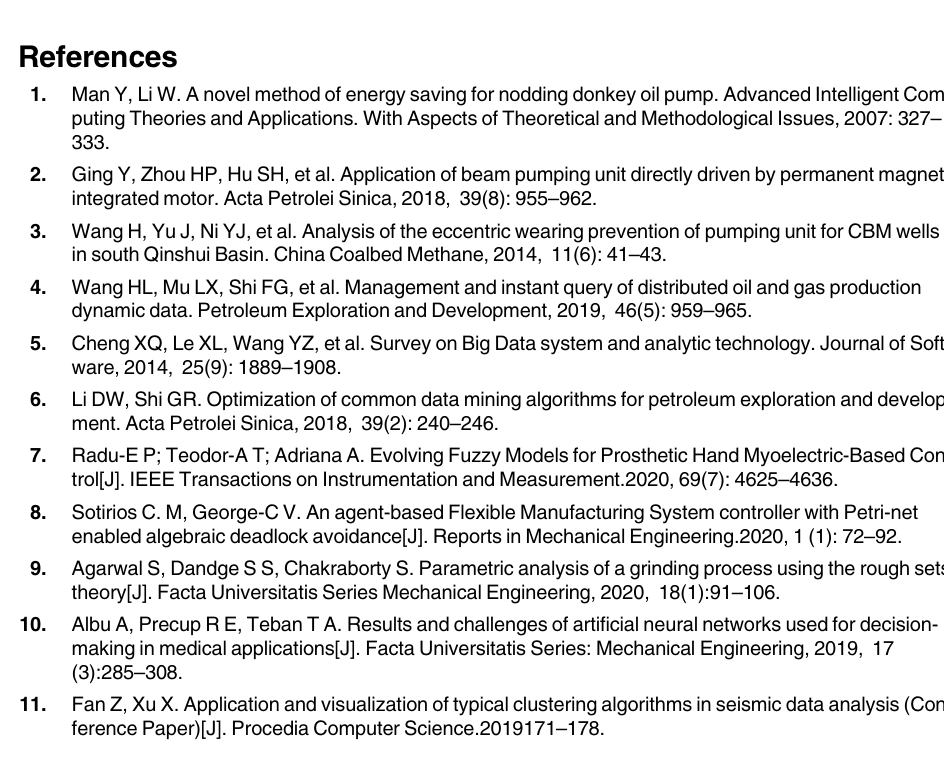
4. Using the improved algorithm clustering results, the measures to improve the efficiency of the block system are summarized. In terms of motor parameters, the power consumption should be increased to increase the input power, which, in turn, increases the utilization rate of the motor. In terms of operating parameters, relevant operations should be carried out to indirectly increase the water content, daily fluid production, oil pressure and casing pressure. In terms of downhole parameters, pump efficiency should be improved and the depth of the pump should be reduced under the condition of satisfying